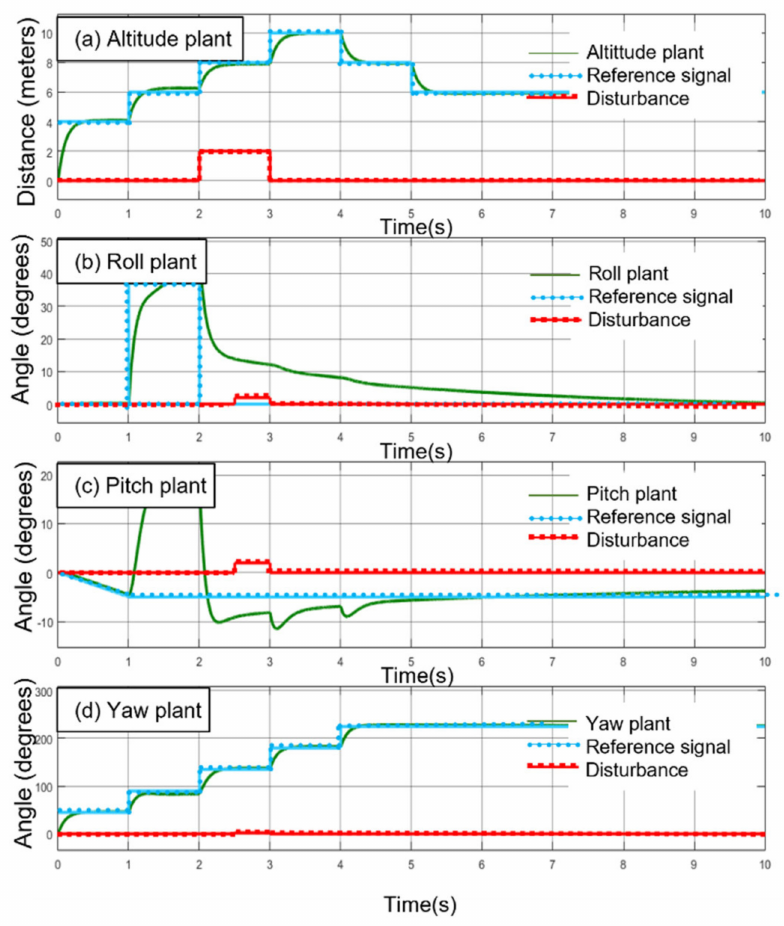
Figure 14. PID simulation results. ( a ) Altitude plant, ( b ) roll plant, ( c ) pitch plant, ( d ) yaw